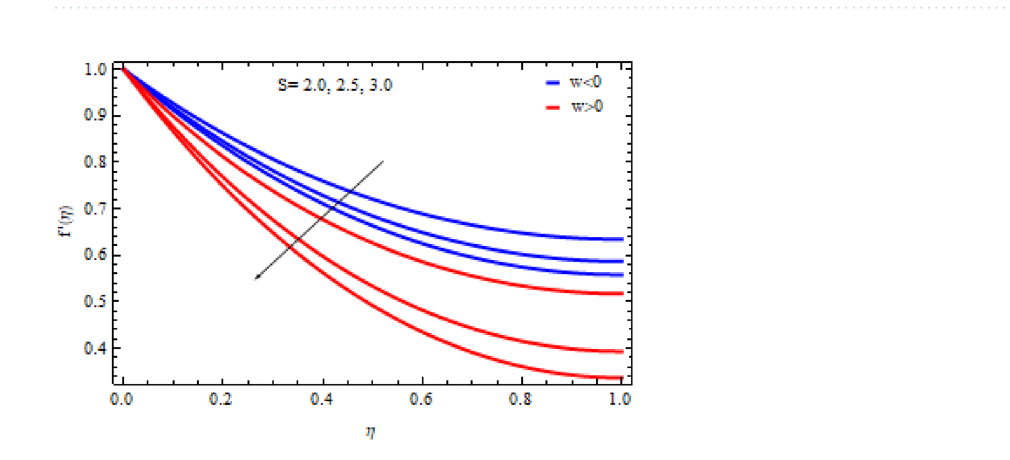
Figure 3. Temperature field by M.